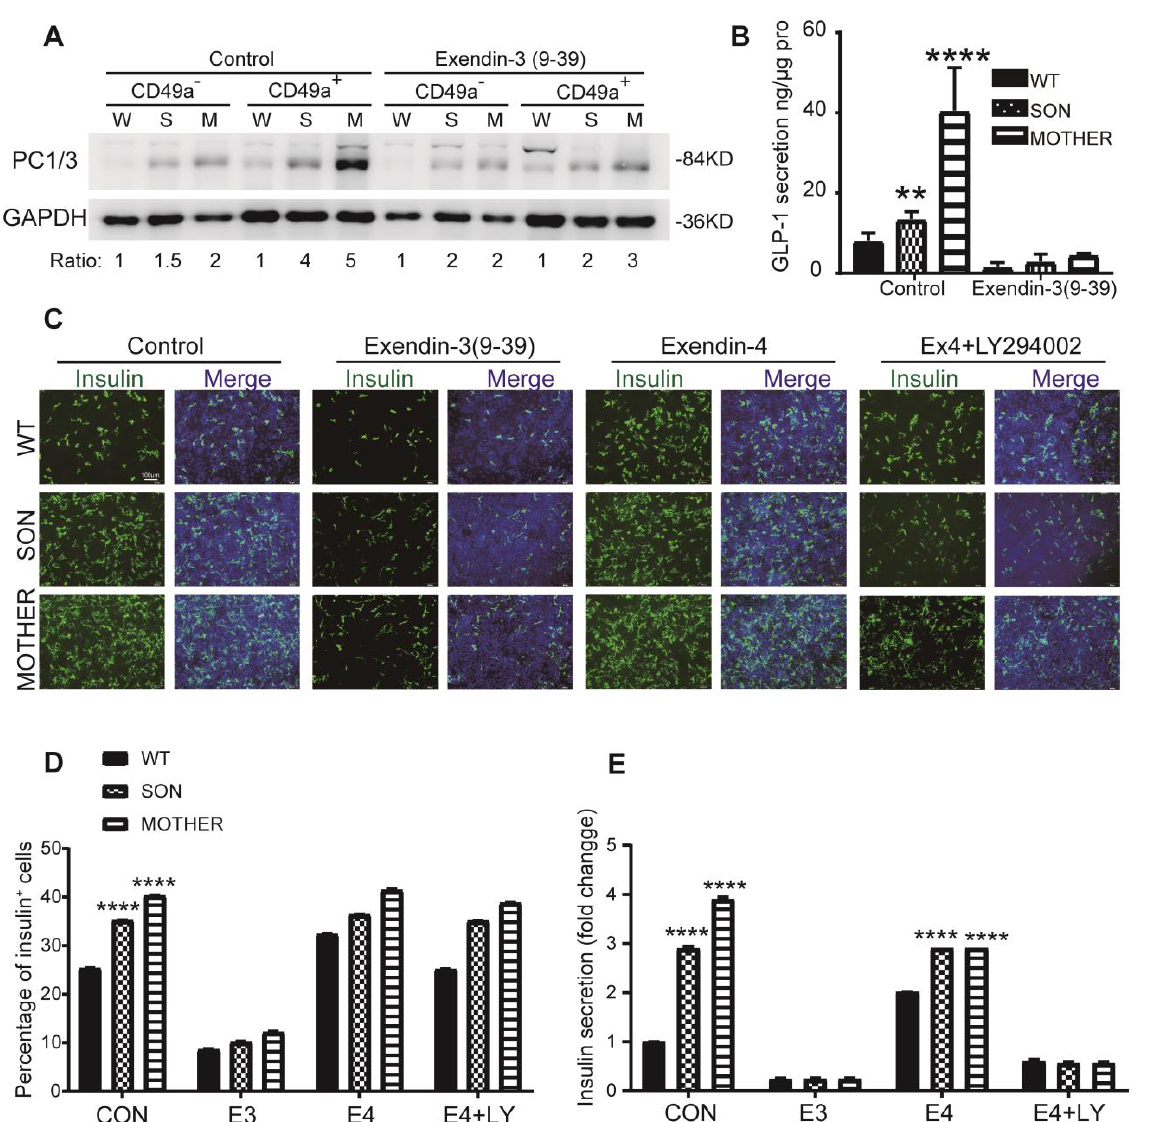
Figure 5. Inhibition of the GLP-1R with GLP-1 competitive ligand, Exendin-3 (9-39) inhibited the increased number of insulin-positive cells in MEN1-derived cells. ( A ) The protein expression of PC1/3 after cell-sorting with CD49a in IPC stage with Exendin-3 (9-39), n = 3. ( B ) ELISA measurement of GLP-1 in IPC stage with Exendin-3 (9-39), n = 3. ( C ) The immunostaining of insulin in IPC stage with Exendin-3 (9-39), Exendin-4 and Exendin-4 + LY294002, respectively, scale bar: 100μm and the quantitative results are shown in ( D ), n = 3. ( E ) ELISA measurement of insulin secretion in IPC stage, n = 3. W-WT, S-SON, M-MOTHER; CON-control, E3-Exendin-3 (9-39), E4-Exendin–4, LY-LY294002. The bar plots ( n ≥ 3 wells per group) are mean ± SEM. ** p < 0.01 and **** p <